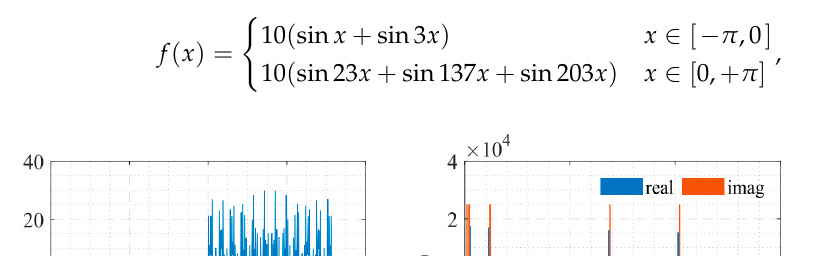
Figure 18. Signal described by Equation (13) with its frequency spectrum. ( a ) The function to be fitted. ( b ) The spectrum of the function.